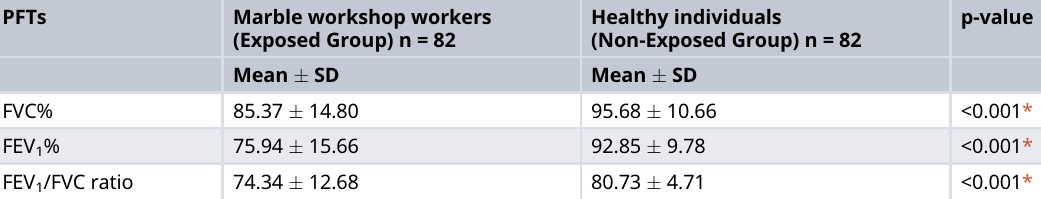
Table 2. Comparison of pulmonary function parameters (PFTs) by study group (n = 164).